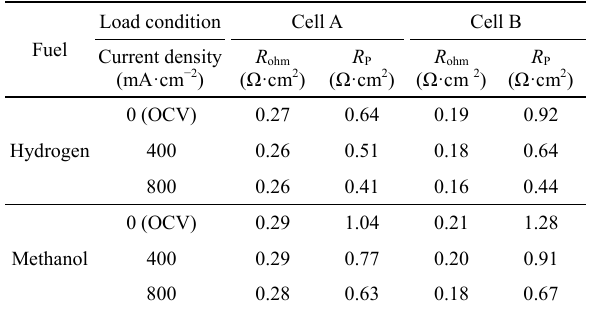
Table 1 Electrochemical parameters obtained from impedance spectra